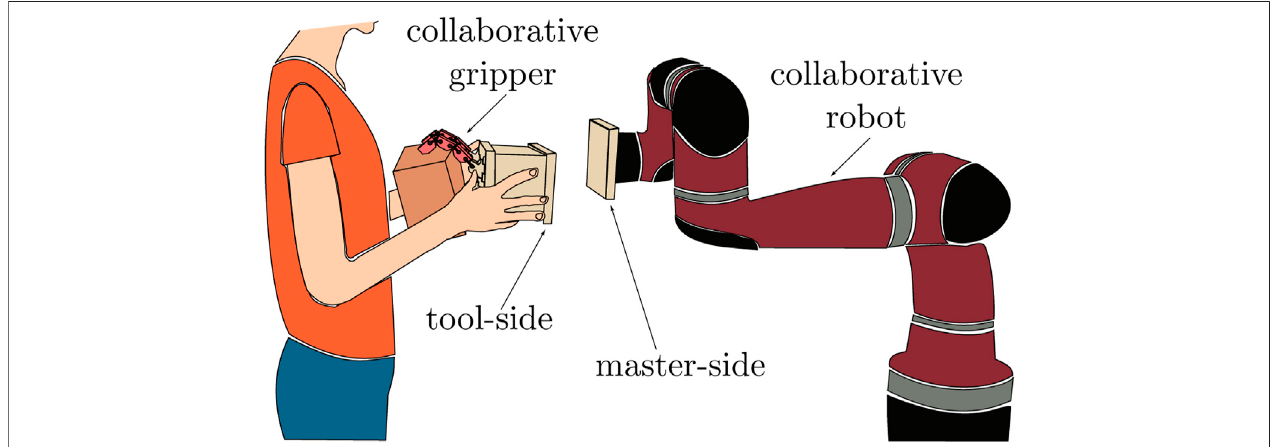
FIGURE 1 | Detachable grippers concept: the user can detach and attach different end-effectors to a collaborative robot arm. The gripper can be detached from thearmwhileitisholdinganobjectandtheusercanworkonit( e.g. ,assemblesomeparts),possiblyhelpedbytherobotichanditself.Inthemeantime,therobotarmcan perform other operations. This scenario is possible only using collaborative self-powered grippers that can be safely handled by humans and do not require external power sources to